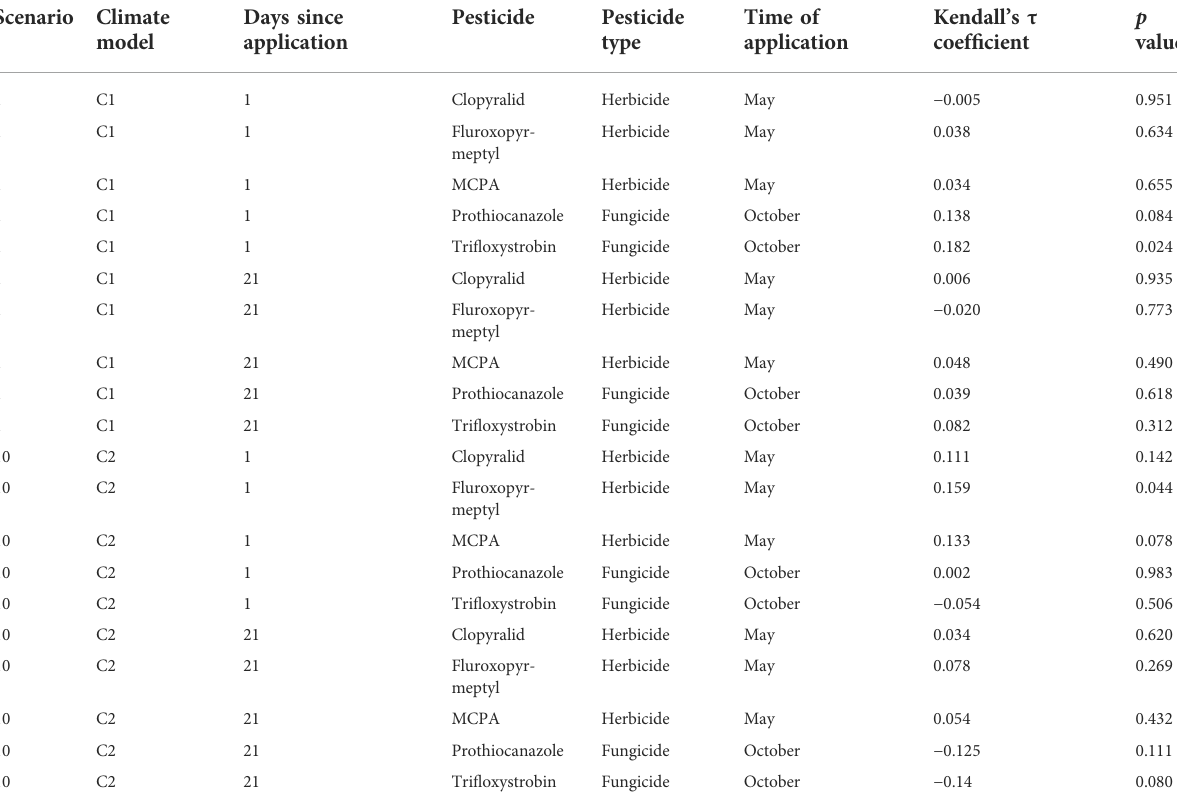
TABLE 5 Results from Mann-Kendall trend analysis of the predicted pesticide exposure concentrations for the following WISPE model settings: climate models C1 and C2; baseline application in May (herbicides) and October (fungicides). The predicted exposure concentration series represent both acute and chronic conditions (day 1 and 21 since application, respectively). For each series, the overall trend for the whole period of years 2000 – 2100 was analyzed. The test statistic τ denotes increasing ( τ > 0) or decreasing ( τ < 0) trend. Scenario Climate